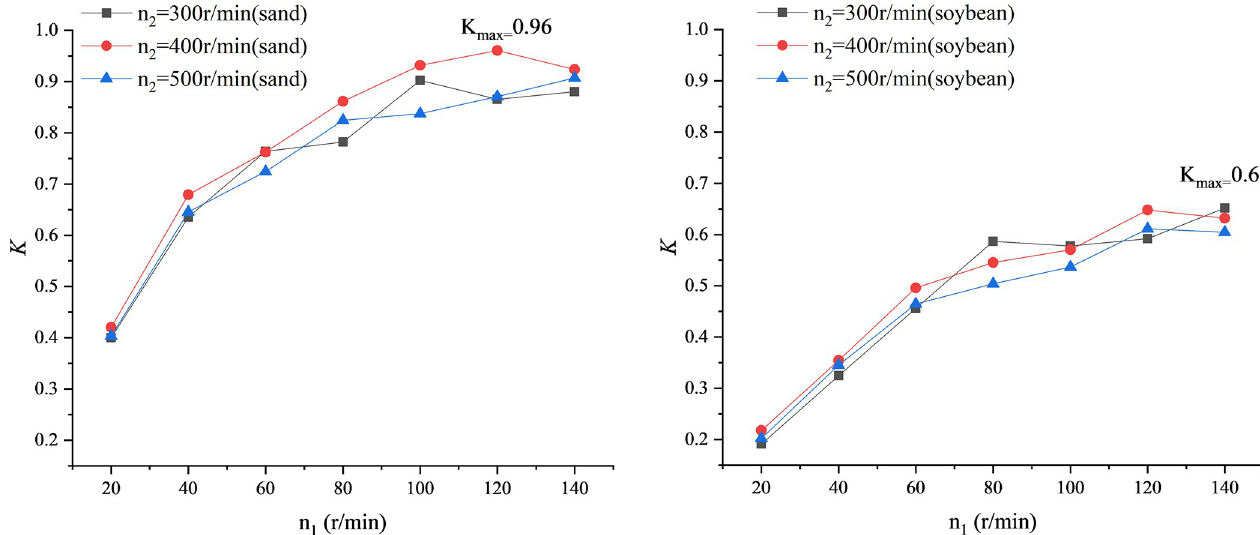
Fig 7. Curve of K versus screw speed n 1 . (A) Material: sand. (B) Material: soybean.